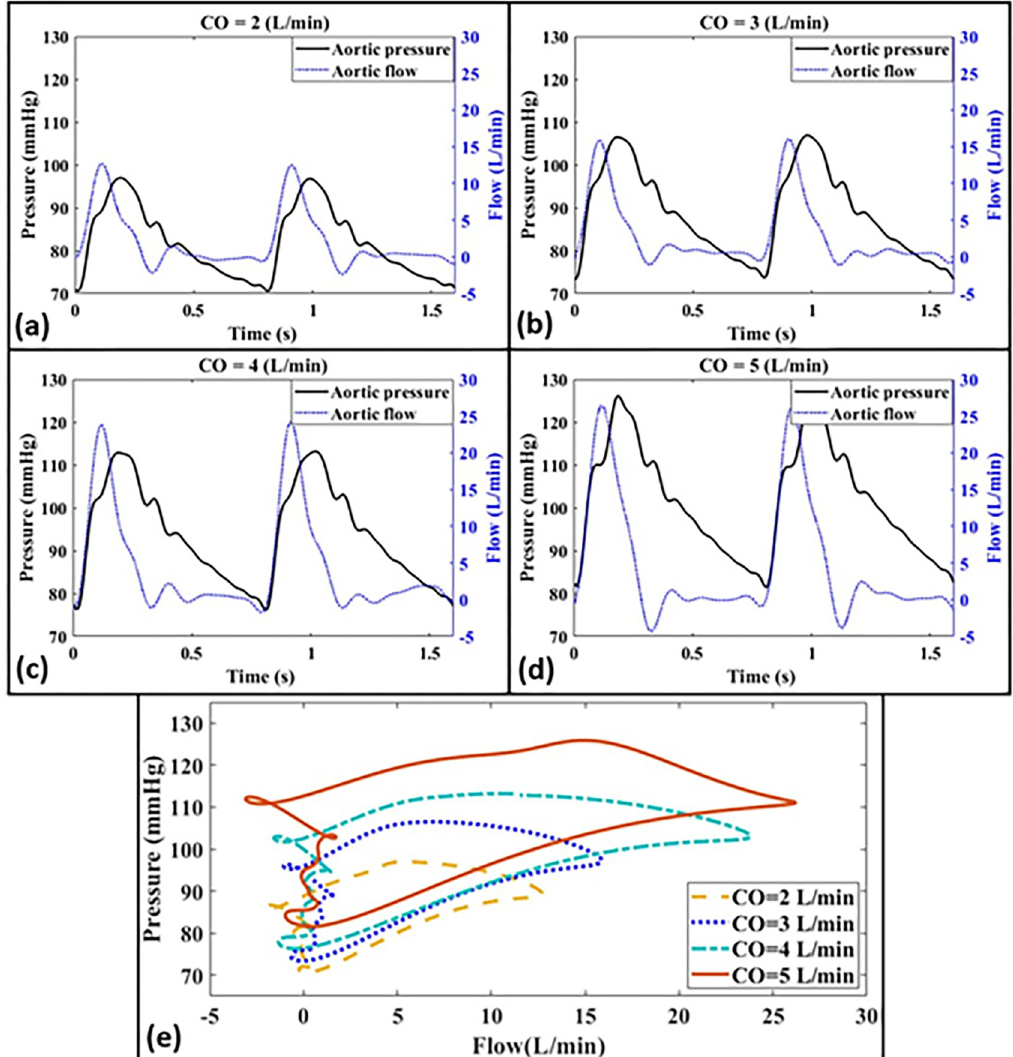
Fig 6. Demonstration of simultaneous aortic pressure and aortic flow measurements for Aorta-3 at different cardiac outputs corresponding to (a) CO = 2 L/min, (b) CO = 3 L/min, (c) CO = 4 L/min, and (d) CO = 5 L/min. The corresponding pressure- flow loops are also presented in the box (e) . Heart rate is 75 bpm for all